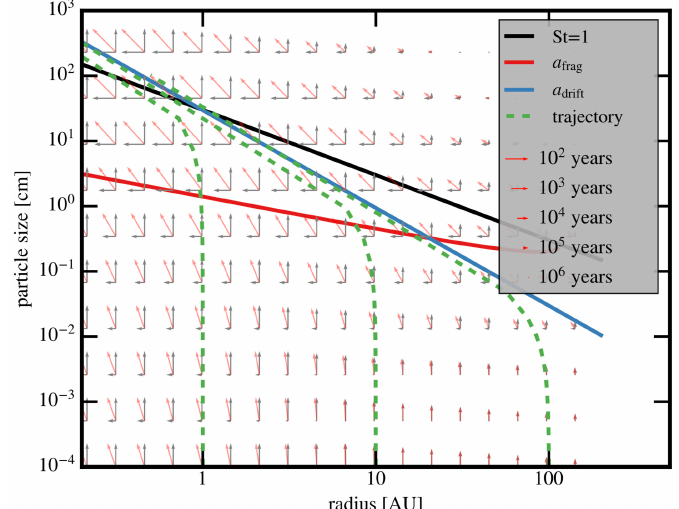
Figure 20. Comparison of growth and drift time scales in a protoplanetary disk [186]. Trajectories for the growth (vertical arrows) and inward aerodynamic drift (horizontal arrows) were calculated at each point in a specific disk model [187]. The arrow length is inversely proportional to the relevant logarithmic timescales. The a frag curve shows the fragmentation barrier above which growth is inhibited. The dashed curves show the trajectories of particles starting at different orbital radii (calculated neglecting fragmentation). The a drift curve is the drift barrier. The solid black curve denotes where the Stokes number is equal to